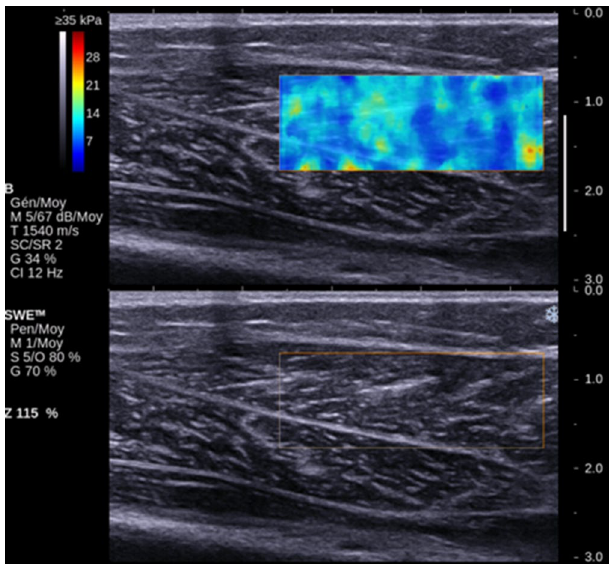
Figure 1. The elastography images of the medial gastrocnemius and below the ultrasonography